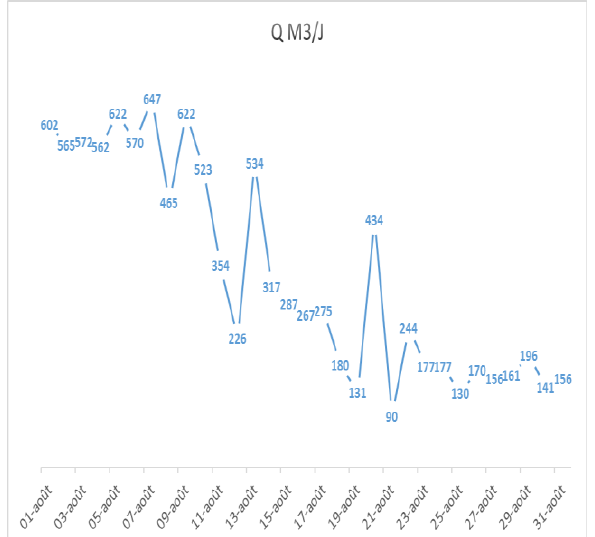
Figure 2. Daily variation in flow rate at the station